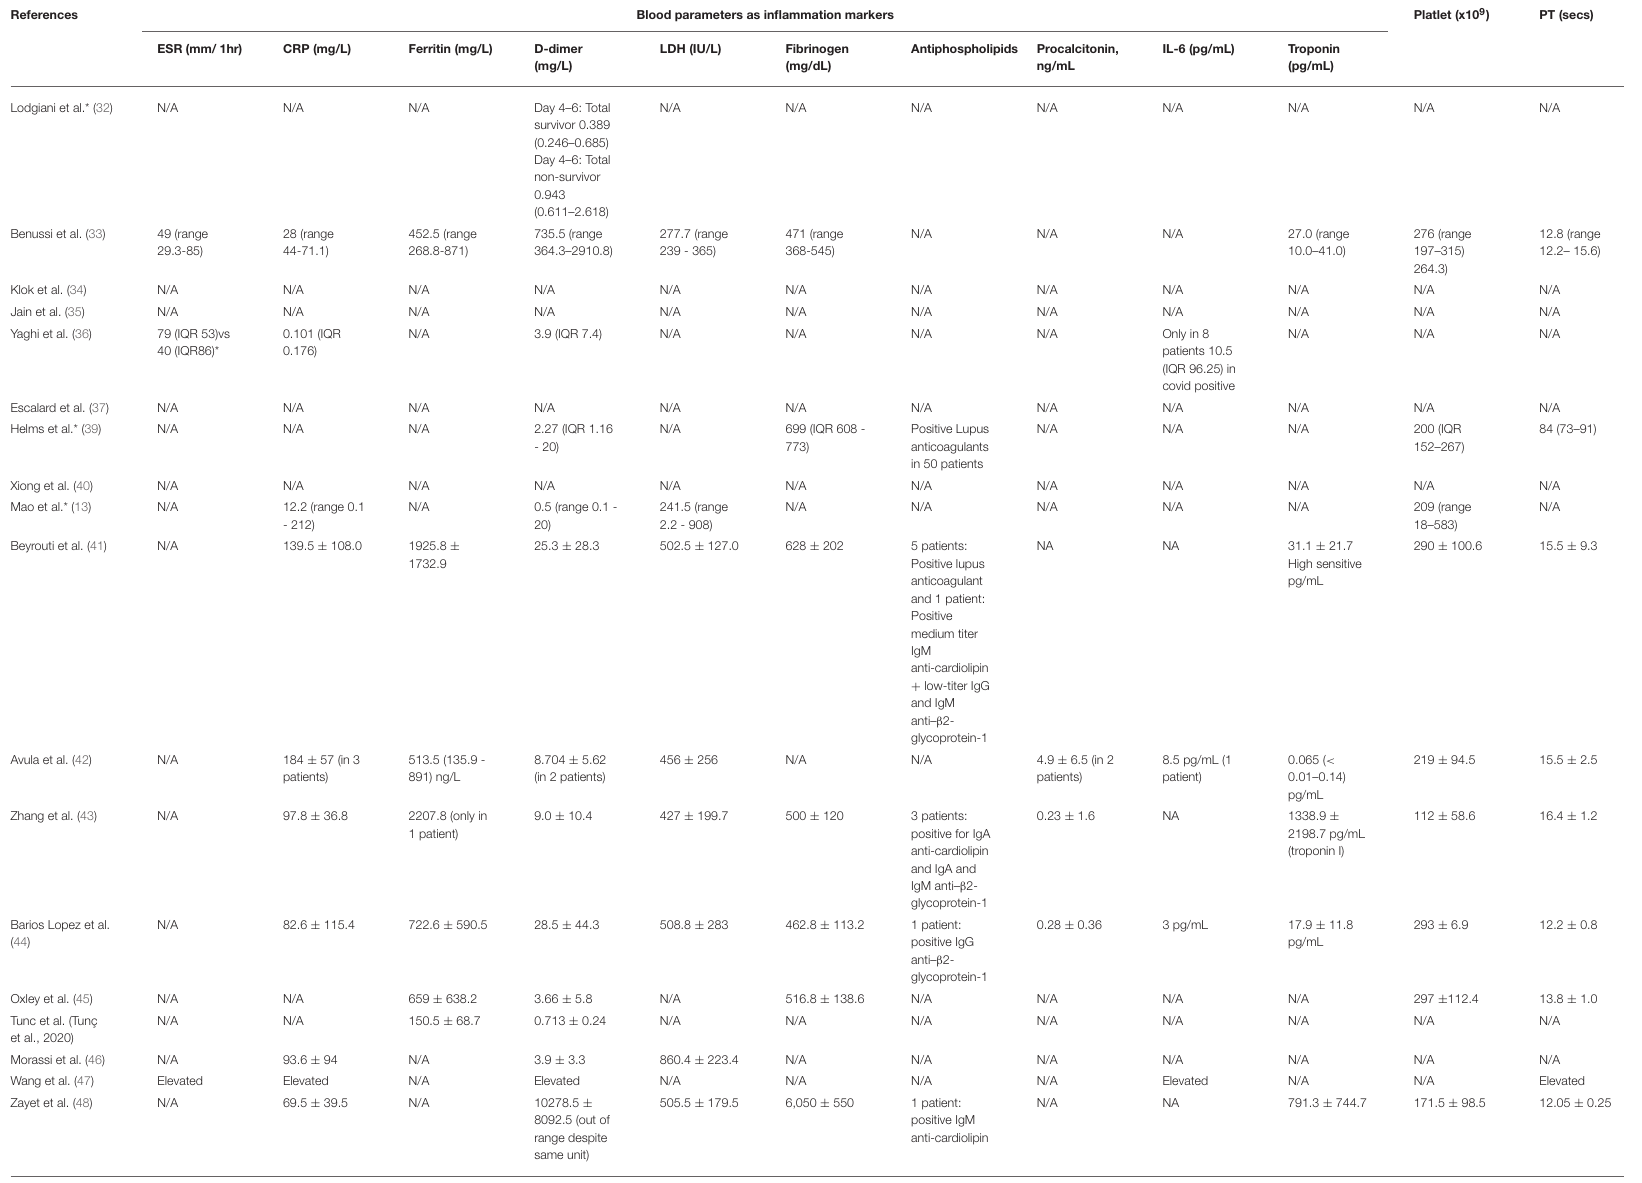
TABLE 6 | Blood parameters as inflammation markers among COVID-19 patients with